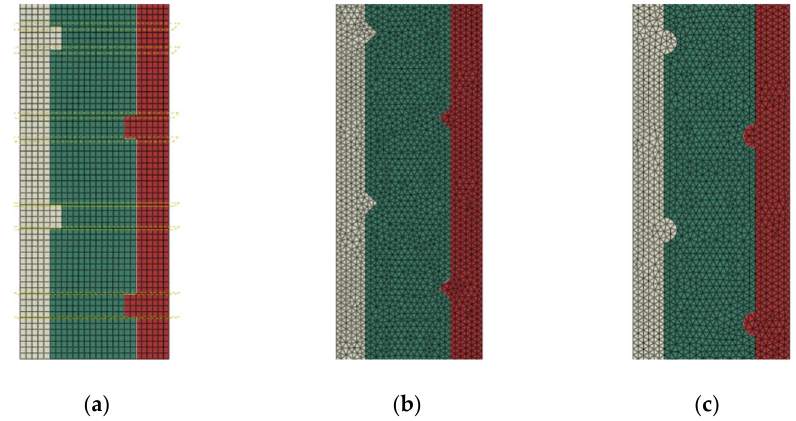
Figure 8. Shear keys of three shapes. ( a ) Rectangle. ( b ) Triangle. ( c ) Semicircle.